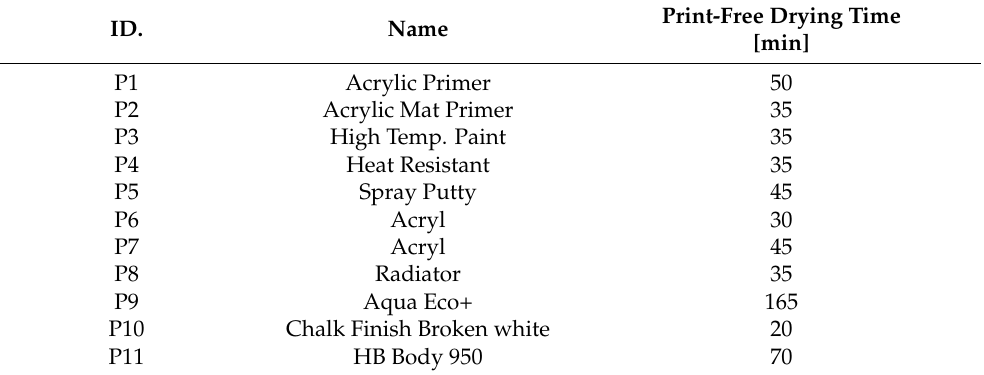
Table 6. Print-free drying time.